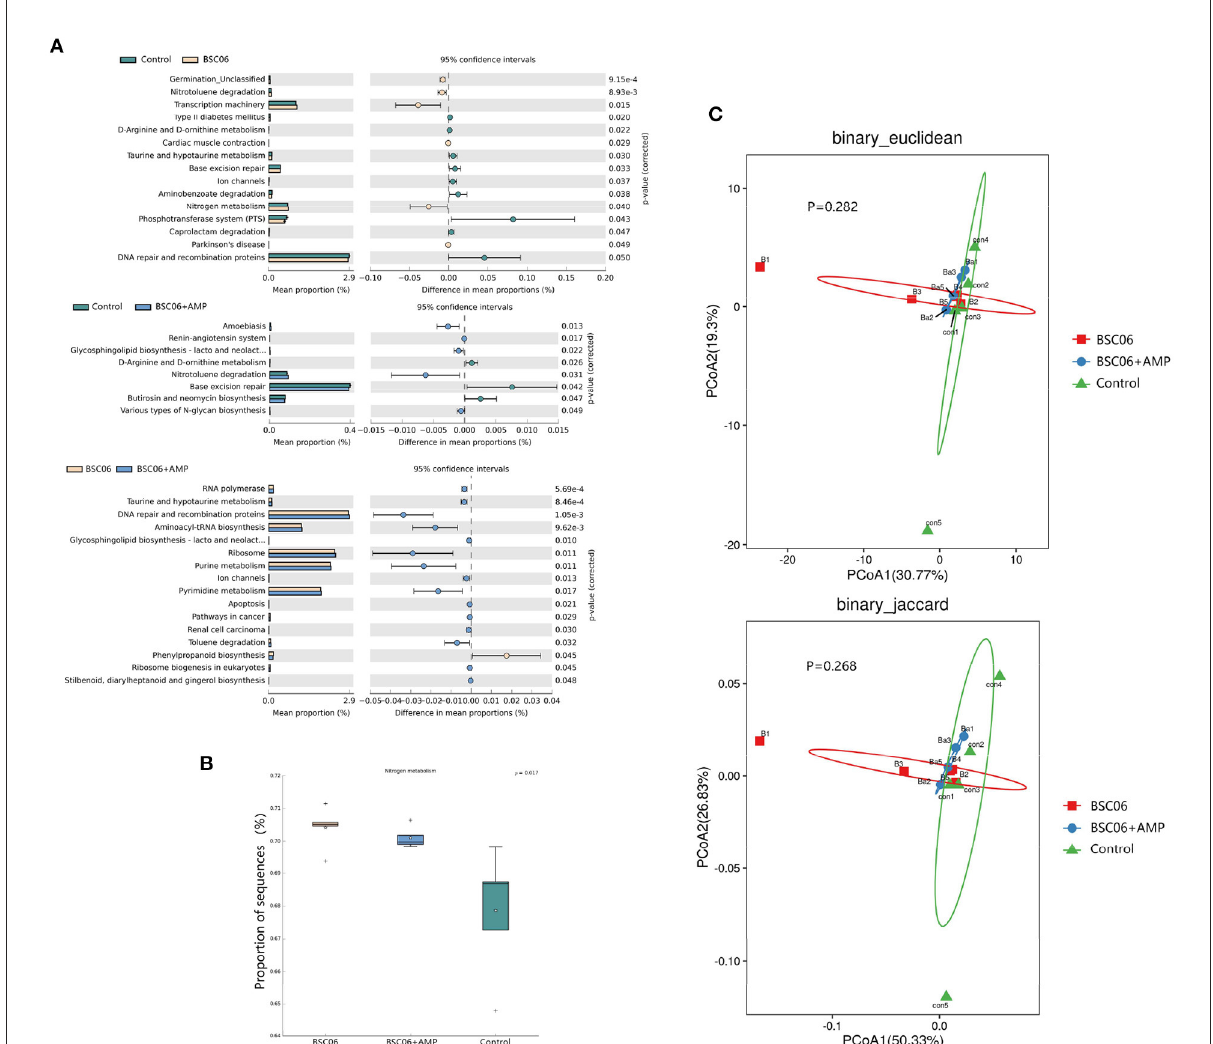
FIGURE8 Predicted functions and diversity in the gut microbiota. (A) Extended error bar plot for two-group analysis module comparison of PICRUSt predicted KEGG function data using Welch’s t -test. (B) Abundance of microbiota related to nitrogen metabolism. (C) PCoA analysis of KEGG